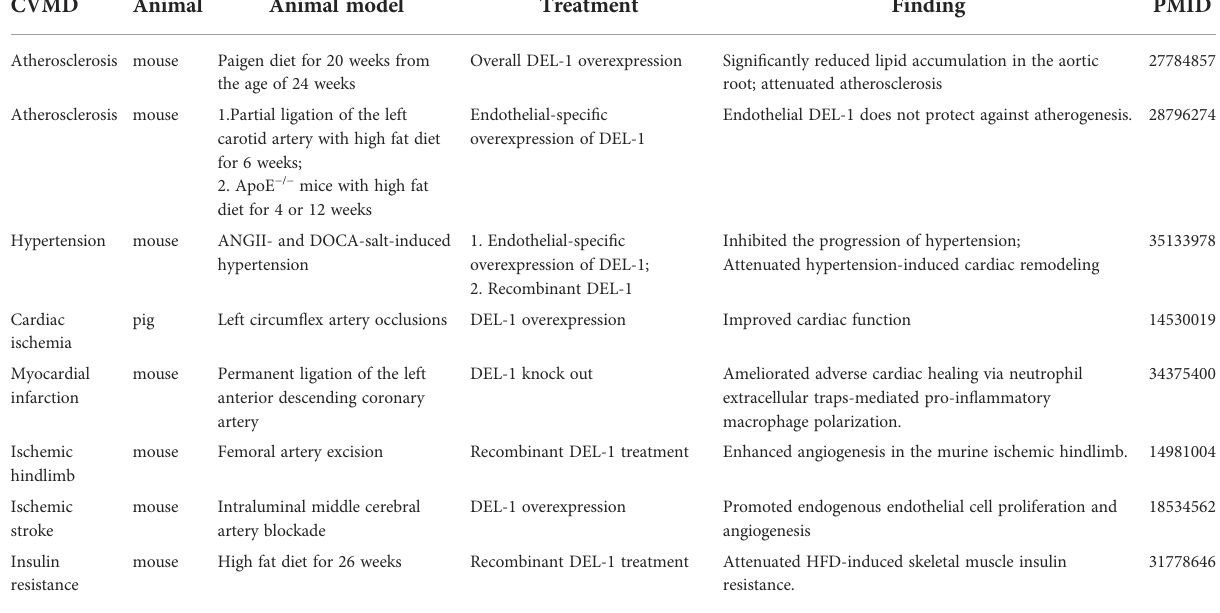
TABLE 1 Roles of DEL-1 in cardiovascular and metabolic